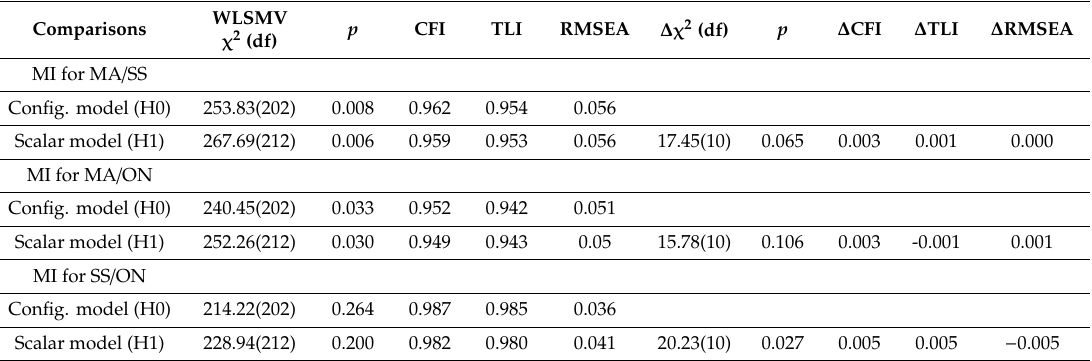
Table 2. Measurement of invariance in the CFA